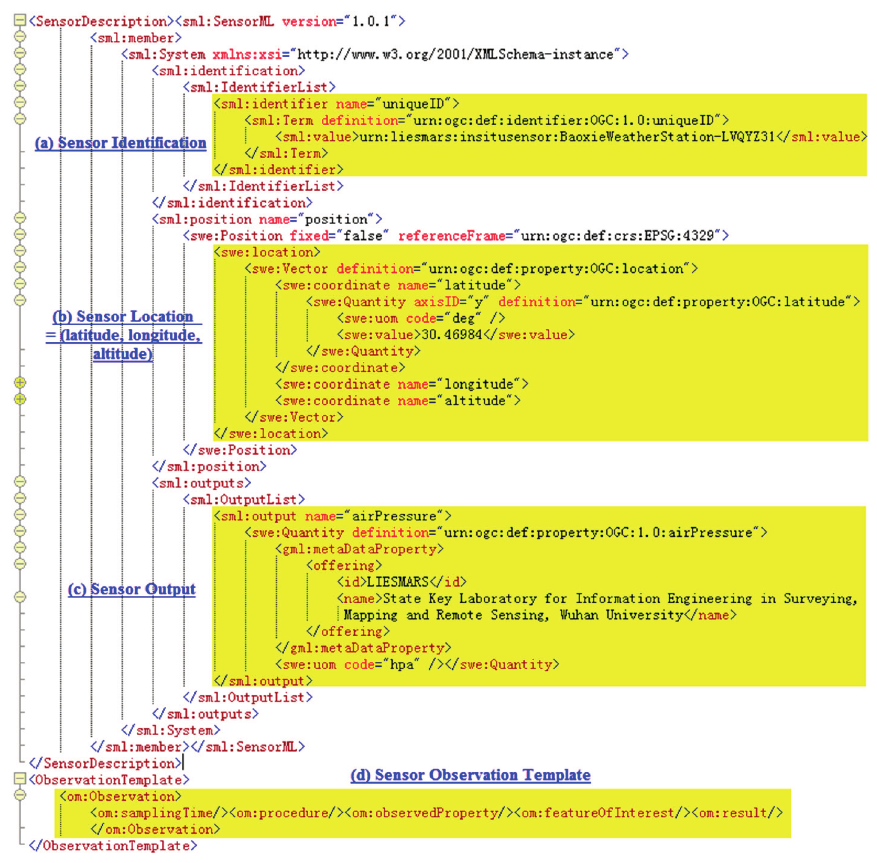
Figure 6. Description of LYQYZ31 barometer for registration.